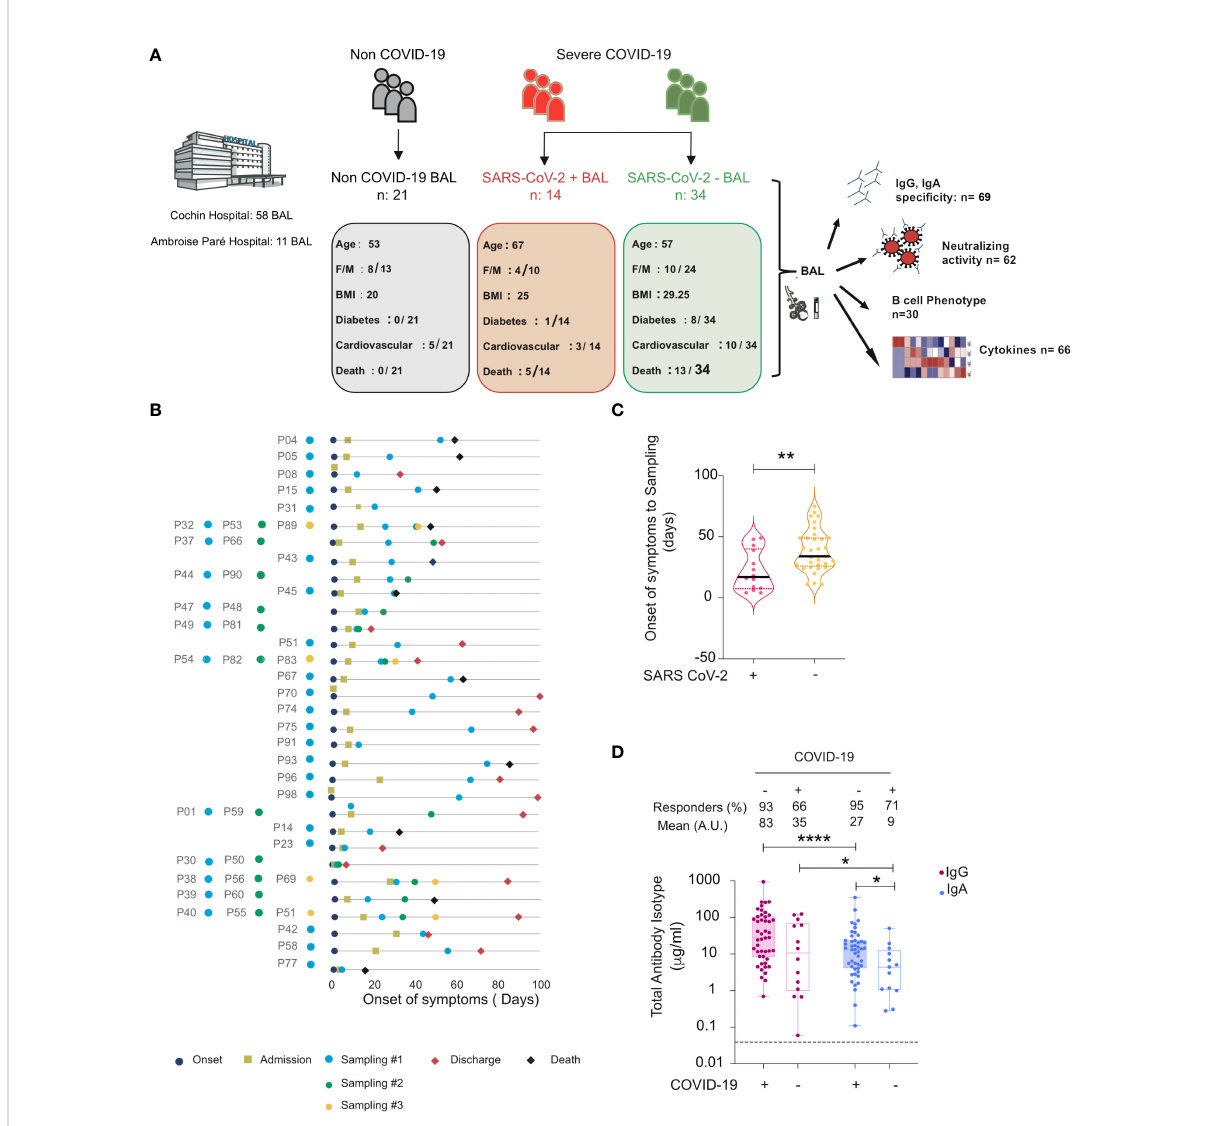
FIGURE 1 Total and speci fi c IgG and IgA in BAL from SARS-CoV-2-infected and non-infected individuals. (A) Graphical representation showing the overall study design and the characteristics (number, age, body mass index (BMI), sex (F=female, M=male), diabetes, and fatality rates) of the individuals included in the study. Illustration with images from Servier Medical Art, licensed under the Creative Commons Attribution 3.0 Unported License. (B) Timeline of the course of disease for enrolled patients infected with SARS-CoV-2. (C) SARS-CoV-2 containing (SARS- CoV-2+) samples correspond to the early phase, whereas those lacking virus (SARS-CoV-2 − ) correspond to a late phase of the disease. Violin plots of time from onset of symptoms to sampling for each sample in SARS-CoV-2+ and SARS-CoV-2 − BAL. p -Values were calculated by using Mann – Whitney test. (D) Comparison between values of total IgG and IgA ( m g/ml) in BAL from SARS-CoV-2-infected individuals (SARS-CoV-2+ and SARS-CoV-2 − BAL) and COVID-19 non-infected individuals. p -Values were calculated by using Wilcoxon test: *, p < 0.05; **, p < 0.01; ****, p < 0.0001. Dashed line: cutoff value for antibody detection. Negative values are not shown. BAL for bronchoalveolar